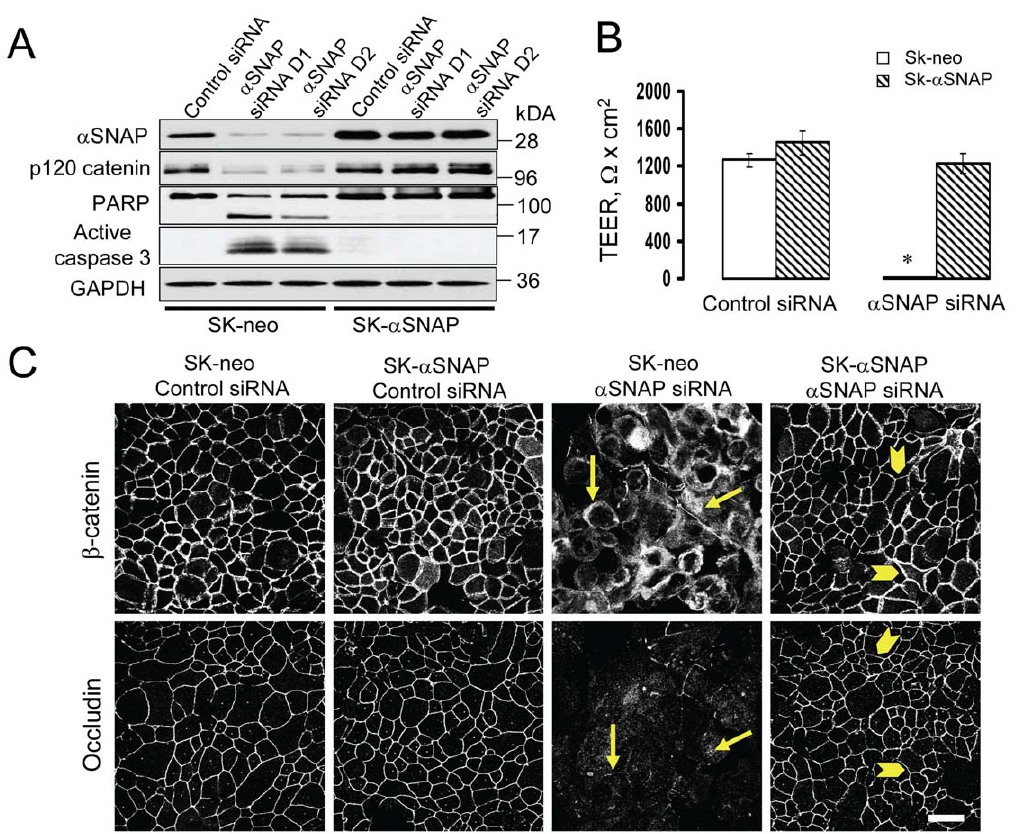
Figure 4. Junctional disassembly and apoptosis in a SNAP-depleted cells can be rescued by expression of siRNA-resistant bovine a SNAP. ( A ) Immunoblotting analysis shows preserved a SNAP level in SK-CO15 cells with stable expression of bovine a SNAP (SK- a SNAP) after siRNA depletion of endogenous human protein. Comparing to the control cells (SK-neo), such bovine a SNAP overexpression completely prevents induction of apoptosis ( A ), disruption of the paracellular barrier ( B ) and AJ/TJ disassembly ( C, arrowheads ) caused by loss of endogenous a SNAP; # p , 0.01 compared to the control siRNA-treated group (n=3). Scale bar, 20 m m.